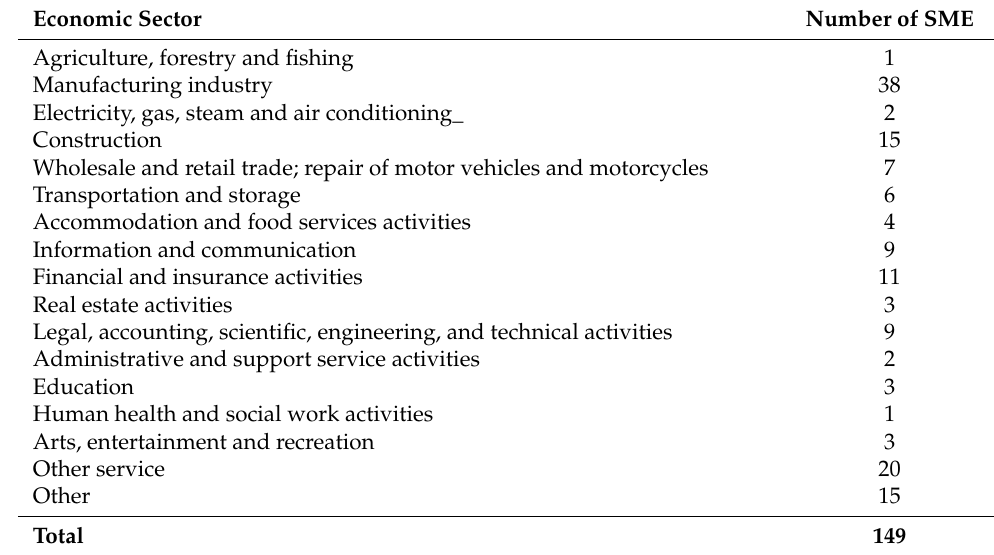
Table 1. SME distribution by economic